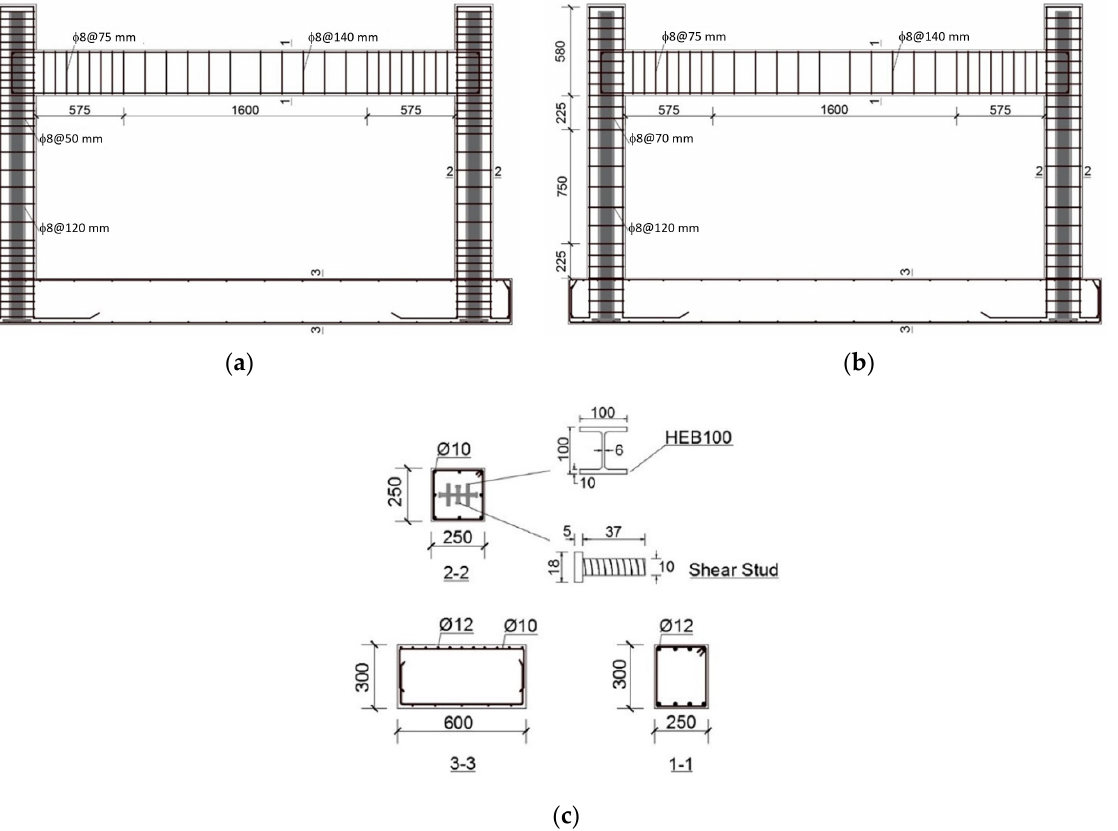
Figure 2. Reinforcement and steel section details of the tested frames: ( a ) HD; ( b ) LD; ( c ) cross-sections [24]. Table 1. Reinforcement details of tested specimens